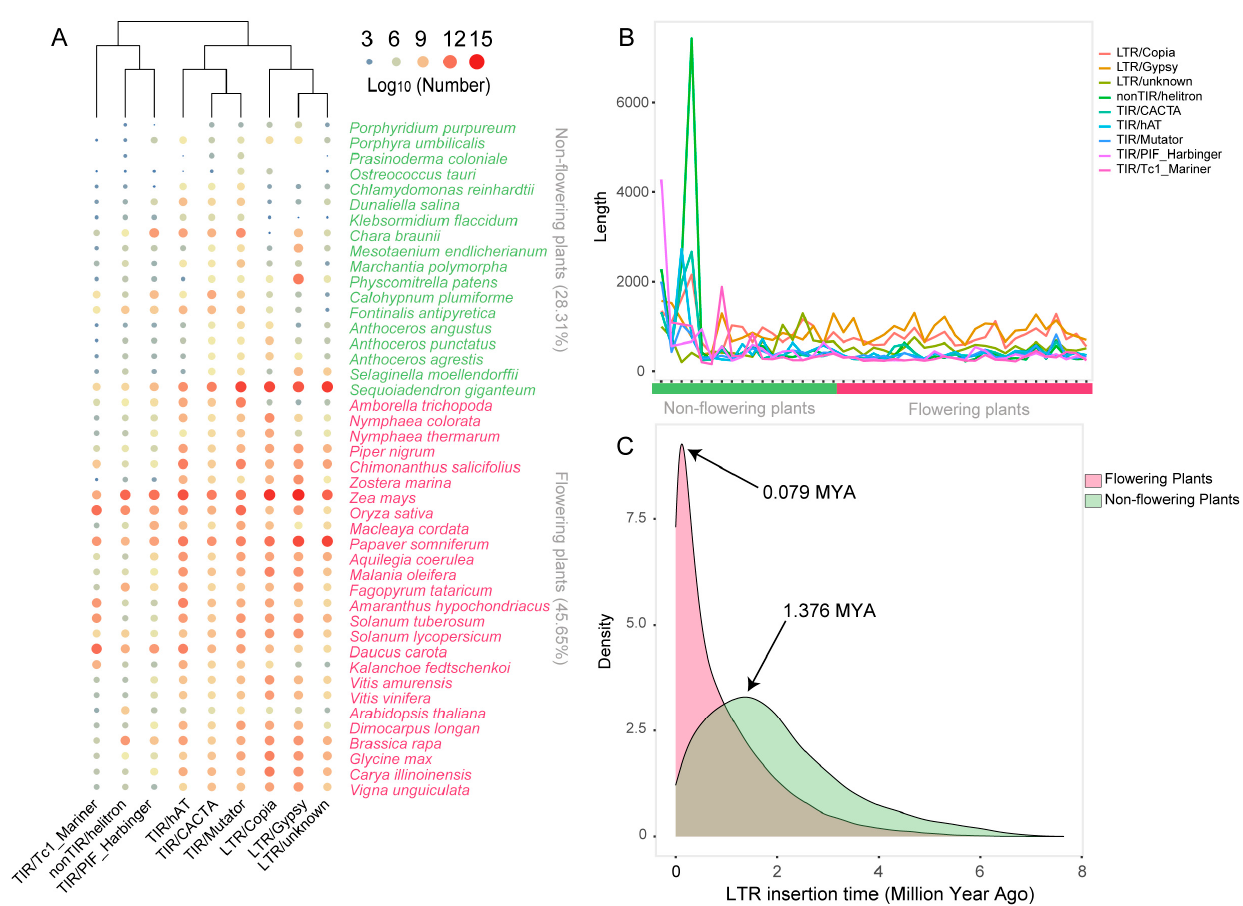
Figure 6. TEs have contributed to the neo-/sub-functionalization of MYB gene duplicates. ( A ) The number of different types of annotated TEs (shown on the column) in 53 representative plants from flowering and non-flowering species. Species names were shown on the right. Each row represents a species, with the green color indicating non-flowering plants and red color indicating flowering plants. Each column represents the type of annotated TEs. Color intensity and circle size correspond to the number of TEs. Larger circle and red color correspond to higher copy number of TEs. ( B ) The length distribution for different types of TEs in flowering and non-flowering plant species. Lines with different color represent different TE types. On the bottom, green bar indicates the non-flowering plants, and the red bar indicates the flowering plants. ( C ) Estimated insertion time of full-length LTR retrotransposons in flowering and non-flowering plants. Red distribution indicates flowering plants and green indicates non-flowering plants. The peak for flowering plants locates at 0.079 million years ago (MYA), and that for non-flowering plants locates at 1.376